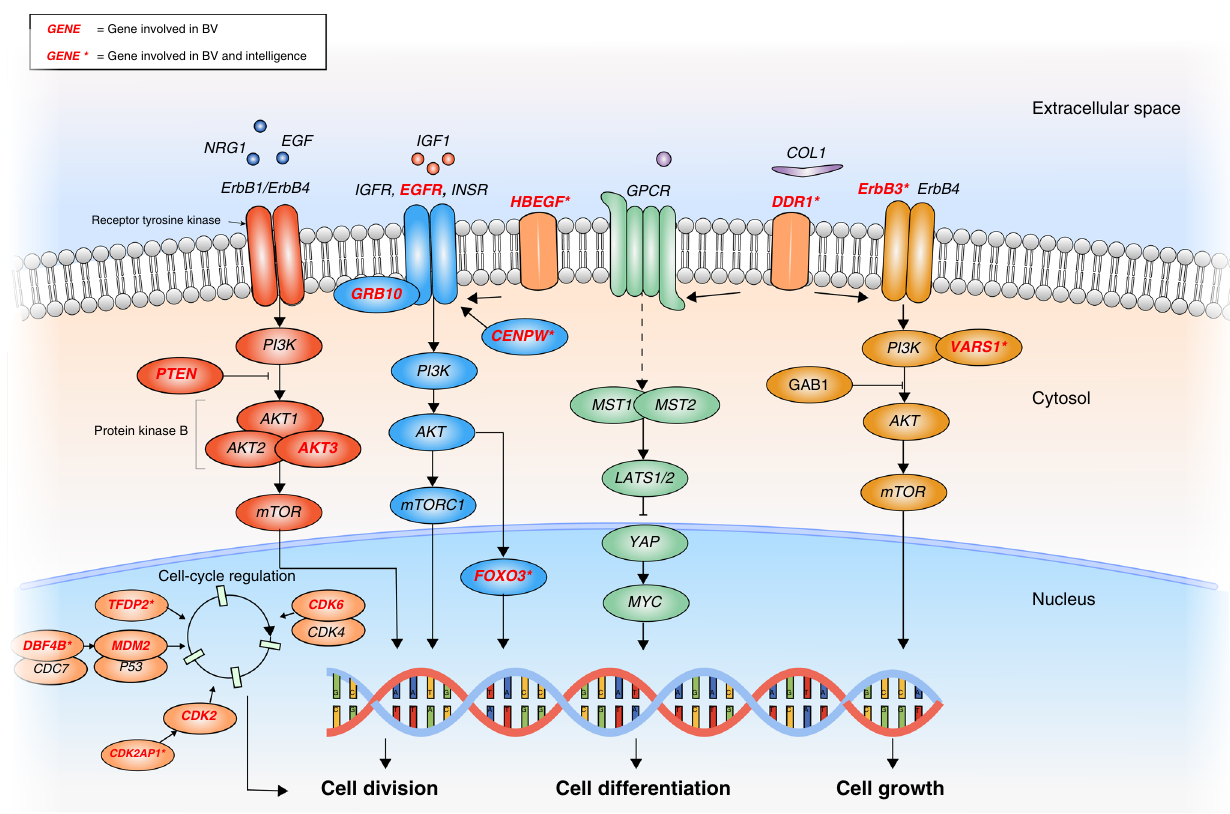
Fig. 4 Schematic representation of cellular signaling pathways involved in BV. Overview of cellular signaling pathways and implicated genes within these pathways that were mapped by the GWAS meta-analysis of BV or overlapped with the genes that were mapped by the GWAS meta-analysis of intelligence. Genes in red font were involved in the meta-analysis of BV, whereas genes in red font denoted by an asterisk were observed in both the BV and intelligence GWAS